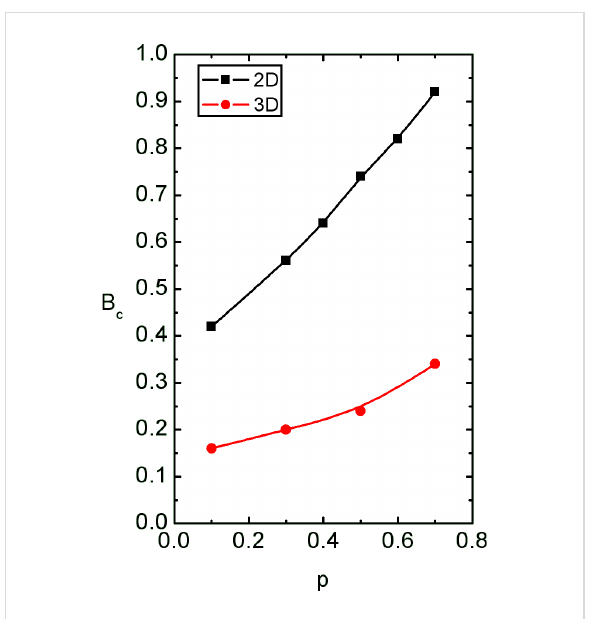
Figure 5: The crossover field B c on varying p . Indicated lines roughly separate ergodic ( B > B c ) and nonergodic regimes ( B < B c ). With increasing p one the degree of frustration within the system increases. Consequently larger values of B are needed to erase disorder induced memory effects. The points are calculated and the lines serve as guides for the eye. (a) W = 2.5, N 0 = 260; (b) W = 2.5, N 0 =